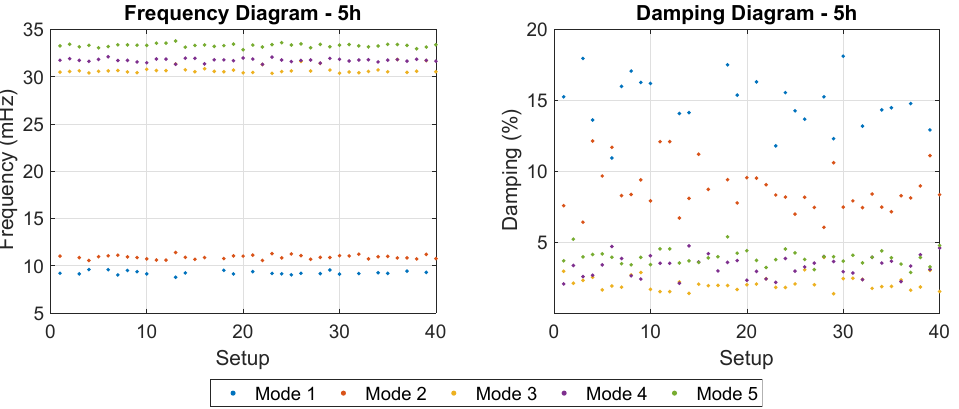
Figure 10. Evolution of the mode frequencies (on the left) and damping coefficients (on the right) in the different setups grouped by color.